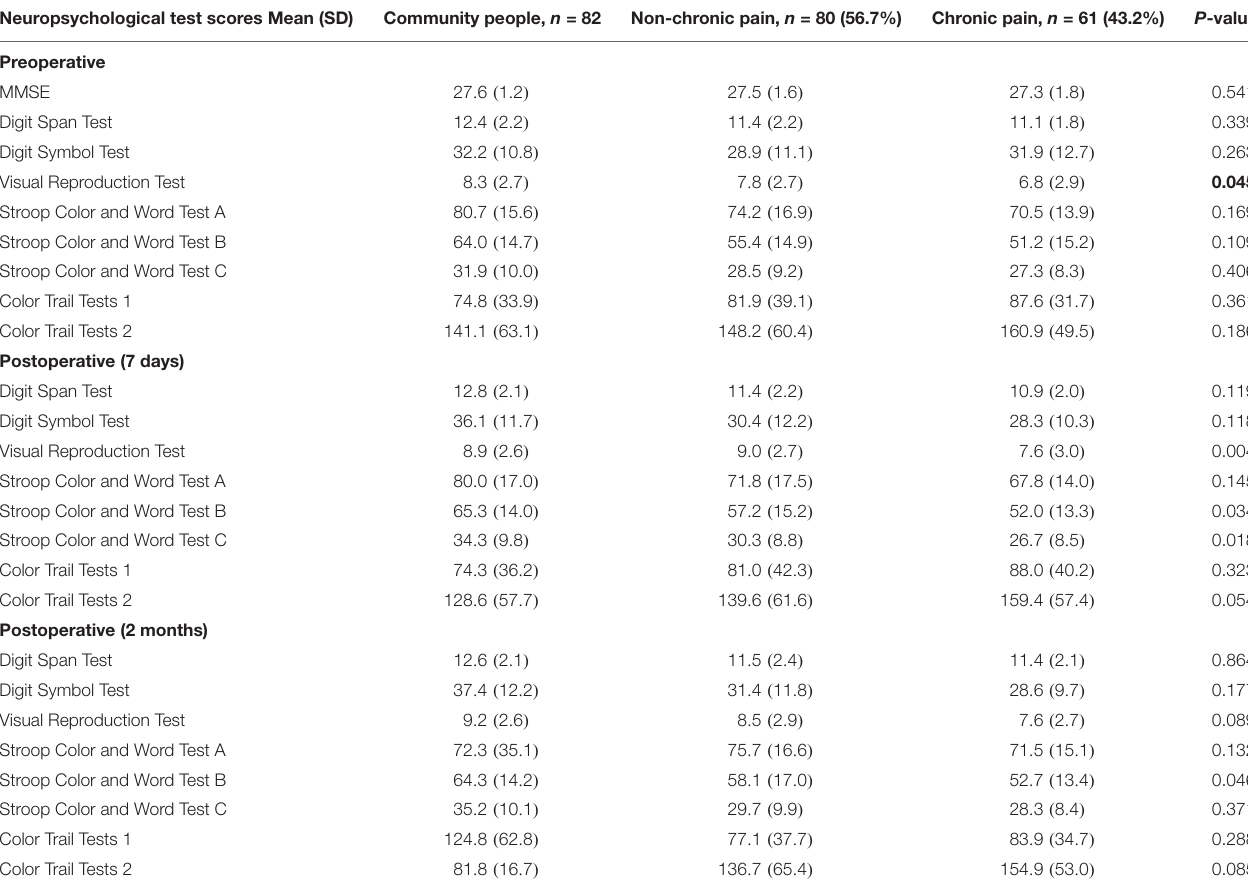
TABLE 6 | Neuropsychological test scores of patients before and after surgery. Neuropsychological test scores Mean (SD) Community people, n = 82 Non-chronic pain, n = 80 (56.7%) Chronic pain, n = 61 (43.2%)